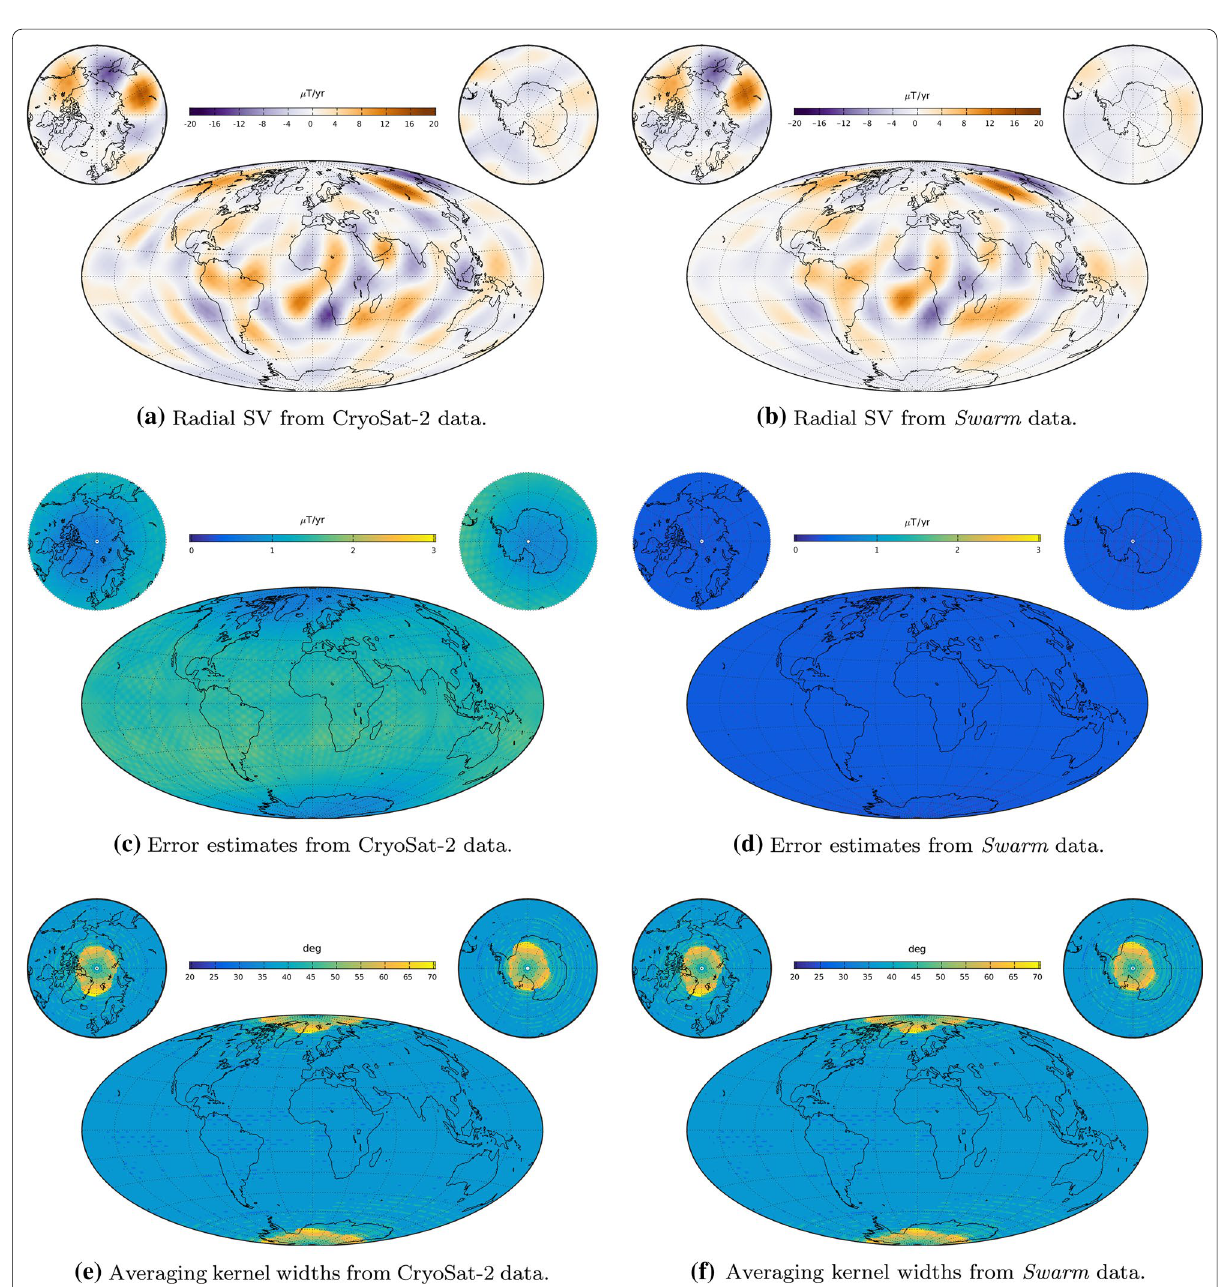
Fig. 7 SOLA CMB radial field SV estimates for epoch 2016.0, derived using data from 2015.0 to 2017.0 (top plots), associated error estimates (middle plots) and averaging kernel widths (bottom plots). Estimates are derived using CryoSat-2 (left plots) and Swarm (right plots) data,